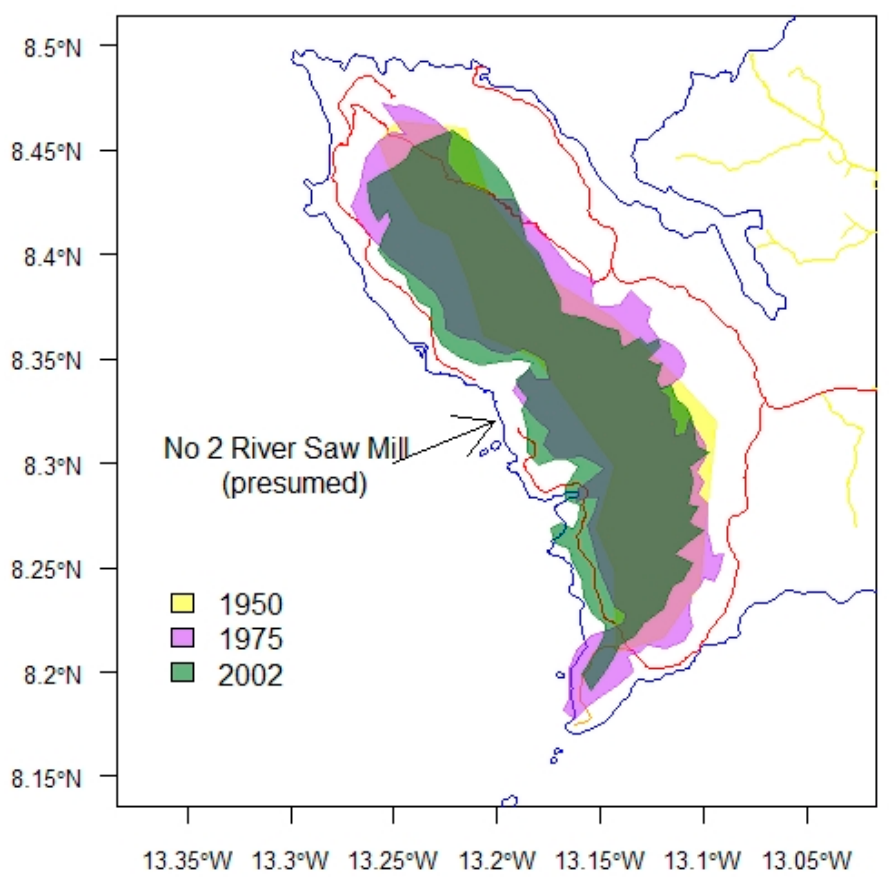
Figure 4. The extent of the Western Area Forest, Sierra Leone, 1950, 1975, and 2002. (Major roads in red, but the Peninsular road is not yet completely rehabilitated).